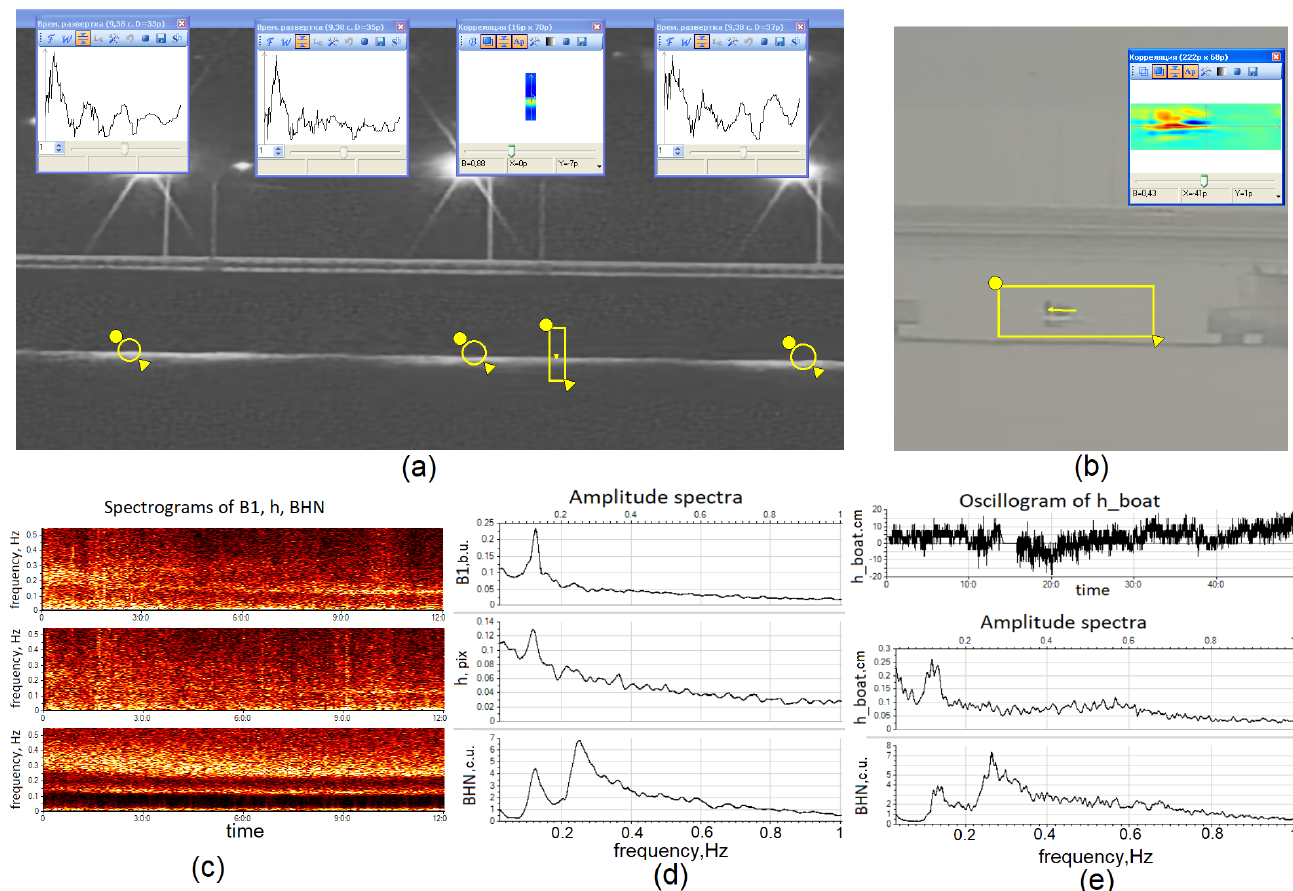
Figure 15. Night QAVIS-measurements of wave characteristics near the low-water bridge ( a ), daytime measurements of a fishing boat vibrations on the waves; ( b ), results of measurement analysis ( c – e ).